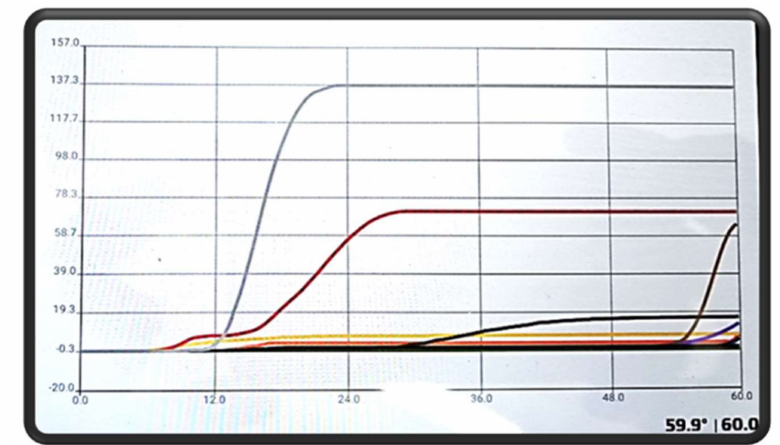
Figure 1. Results for positive samples, gray and red sigmoid curve, and negative samples. This graph was obtained using the software provided by Avantech Group and connected with the ICGene Vet detector. The time required is indicated on the x-axis is indicated, the fluorescence intensity is indicated on the y-axis. Table 3. Comparison of results obtained by LAMP and Rt-PCR for the three sample sources examined: lymph nodes, blood, and conjunctival swabs. Lymph Nodes Blood Conjunctival Swabs Rt-PCR Rt-PCR Rt-PCR LAMP